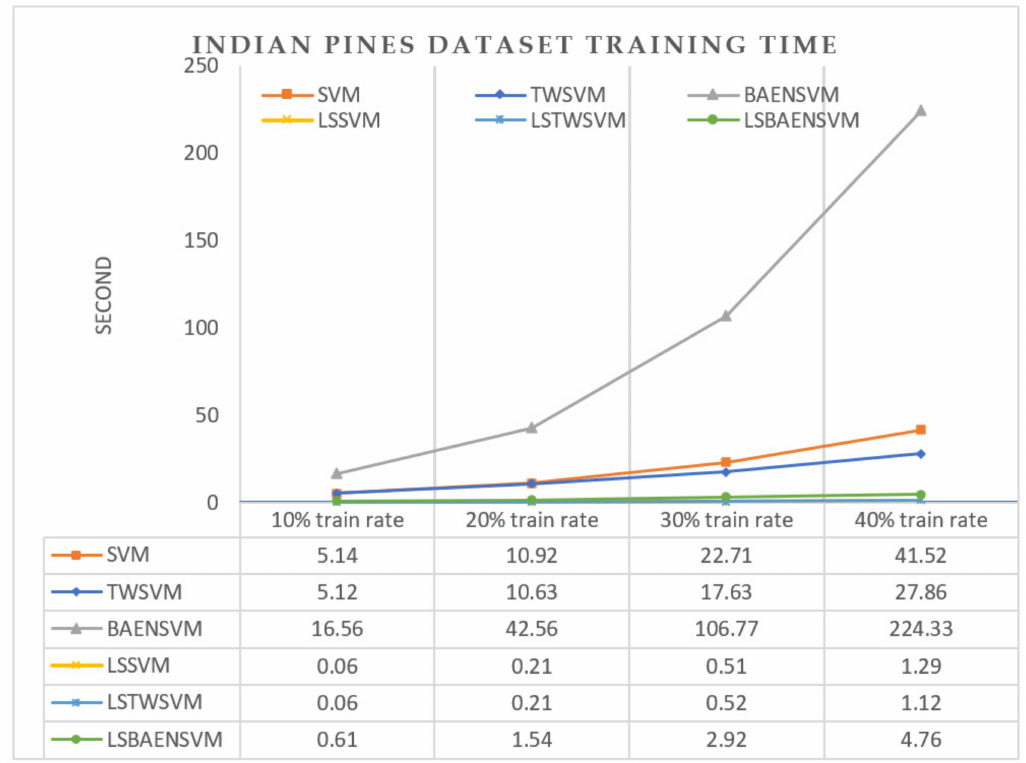
Figure 5. Time-consumption comparison of SVM, TWSVM, BAENSVM, LSSVM, LSTWSVM and LSBAENSVM at different scales using the Indian Pines training